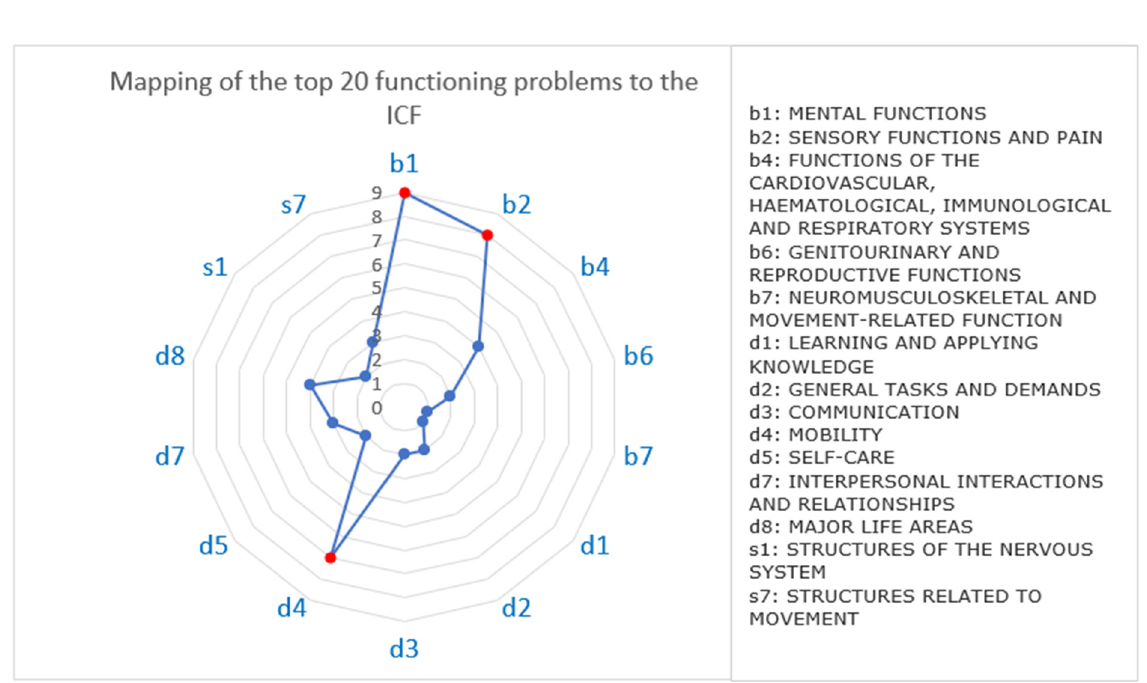
Figure 6. Mapping of the top 20 presenting functioning problems to the ICF domains.